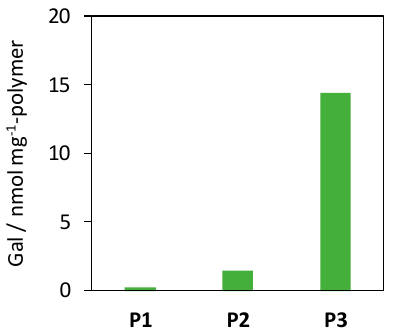
Figure 6. Released galactose from the aggregates in a pH 5 buffer solution above the LCST (40 °C).